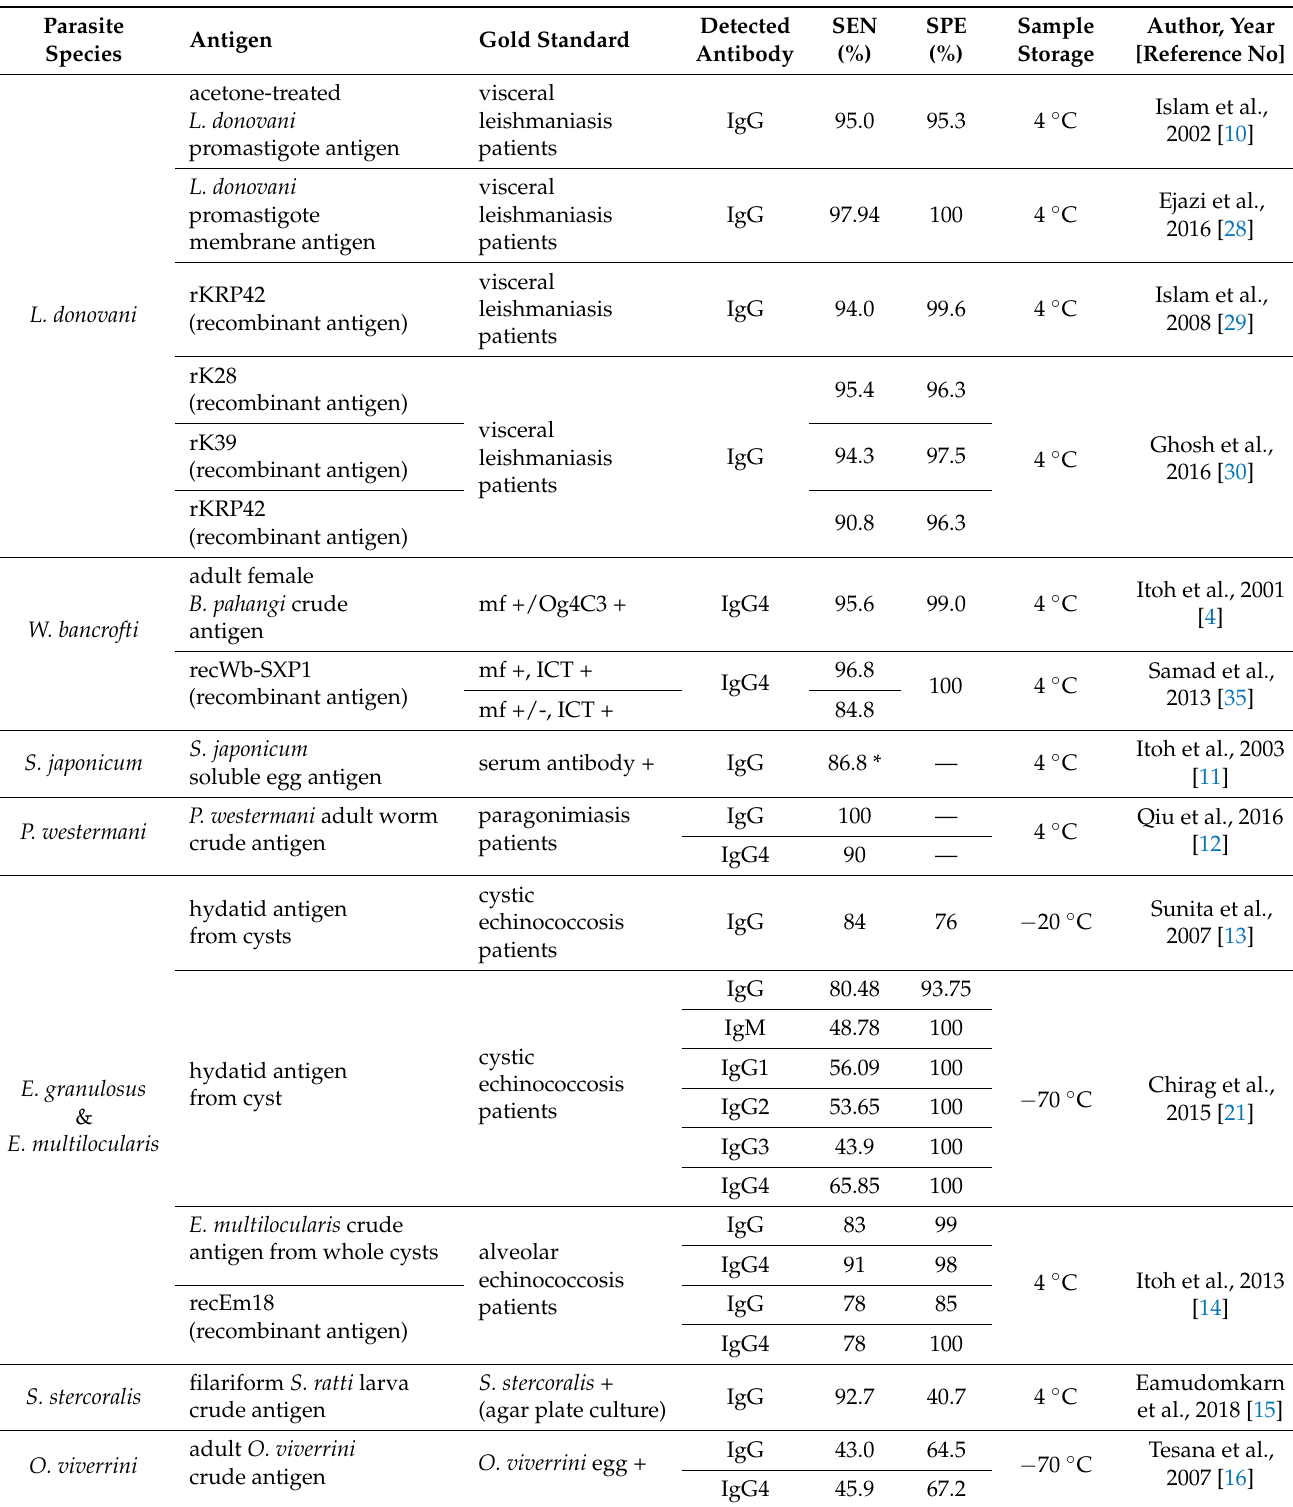
Table 1. Summary of antibody test for parasitosis by urine ELISA. mf: blood smear for microfilariae; Og4C3: ELISA kit to detect filarial circulating antigen; ICT: immunochromatographic card test for filarial antigen; SEN: sensitivity; SPE: specificity. * Percentage of urine antibody positive among serum antibody positive